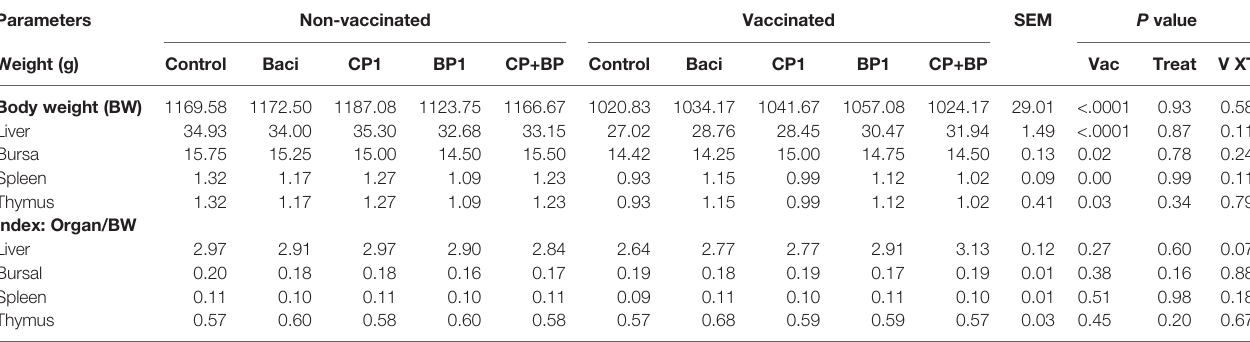
1 Each value represents the least square mean (LSmean) of six replicates (n = 6 pens of at least 45 chickens/pen). Control (basal diet), BACI (basal diet supplemented with 55 ppm bacitracin); basaldietsupplanted with cranberry pomace1% (CP1); blueberry pomace1% (BP1);and cranberry1% and blueberry 1% pomaces together (CP+BP).Vac, themain effectof vaccination; Treat, main effects of treatments; V X T, the interaction between vaccination and treatments.